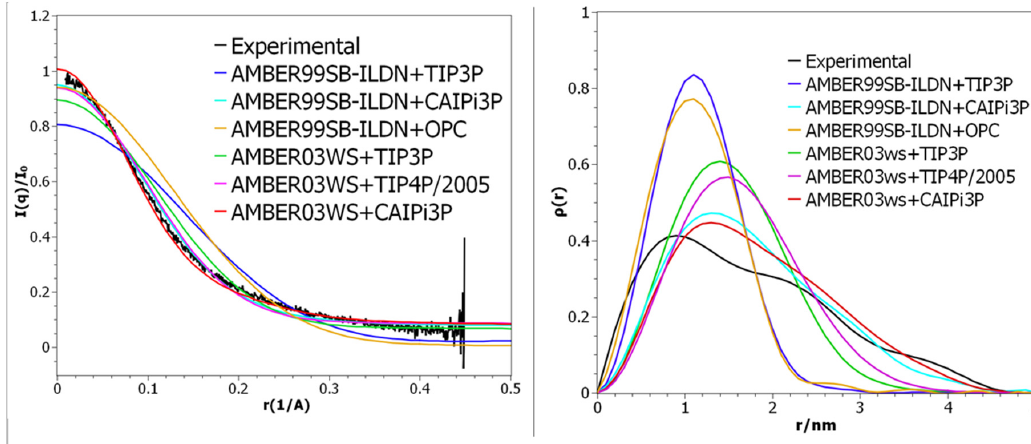
Figure 1. ( Left panel ) Small-angle X-ray scattering (SAXS) intensities, with a focus on the low angle region. ( Right panel ) Pair distance distribution function for histatin 5 SAXS.